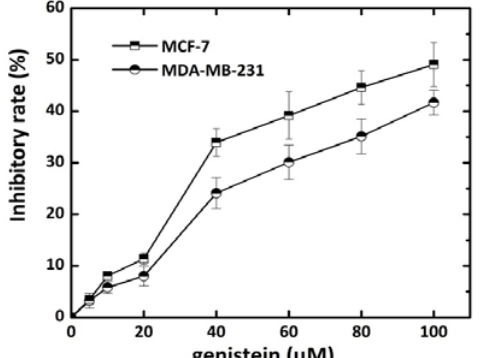
Figure 2. Effect of genistein on the proliferation of MCF-7 and MDA-MB-231 cells. Logarithm growth period cells were incubated with genistein at various concentrations for 48 h, then the proliferation of the cells was determined by the MTT assay. All data are presented as means ± SD from three independent